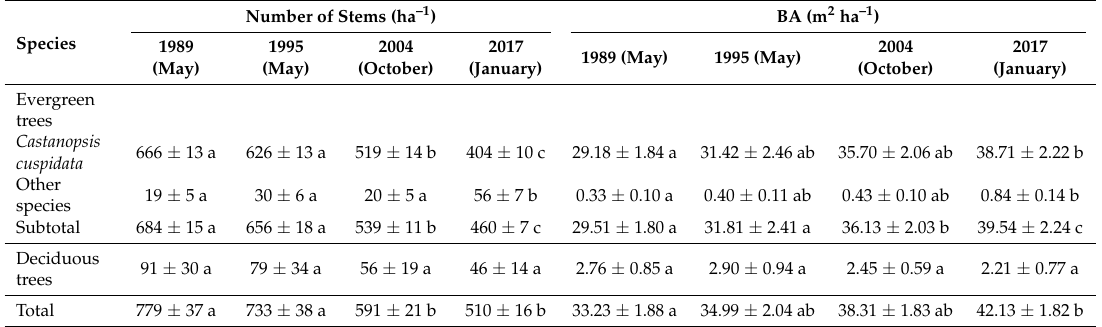
Table 2. Dynamics of basal area (BA; m 2 ha − 1 ) and number of stems (stems ha − 1 ) of each species (DBH ≥ 10 cm) in the permanent plot during the 28-year period a .